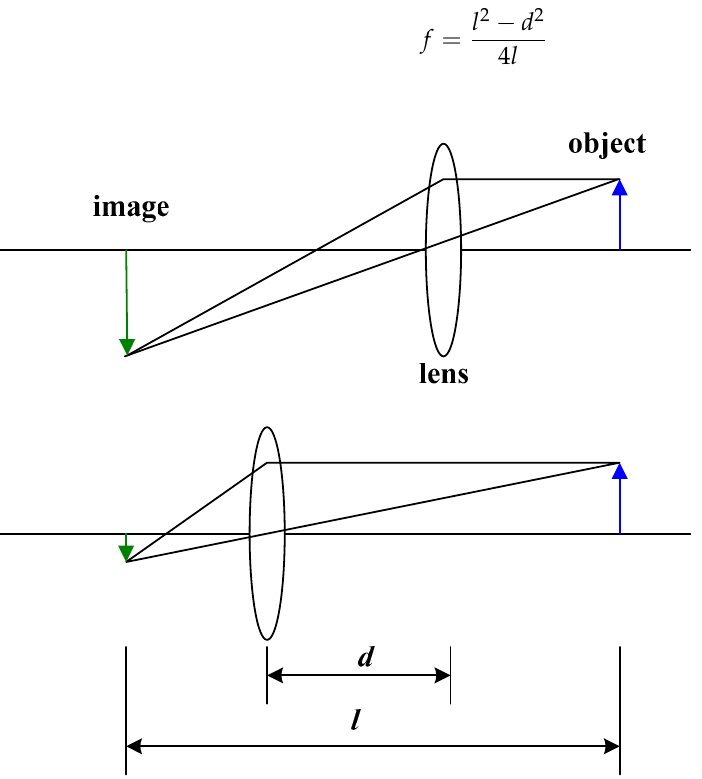
Figure 4. Focal length measurement using two conjugates method.